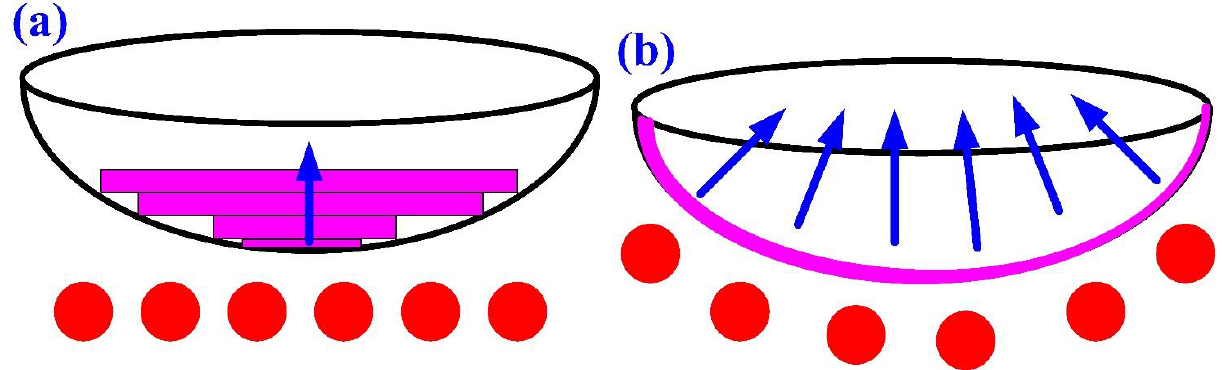
Figure 13. Vulcanization mechanism of a convex lens fabricated by LSR injection mold with ( a ) con- ventional heating channel and ( b ) CHC.